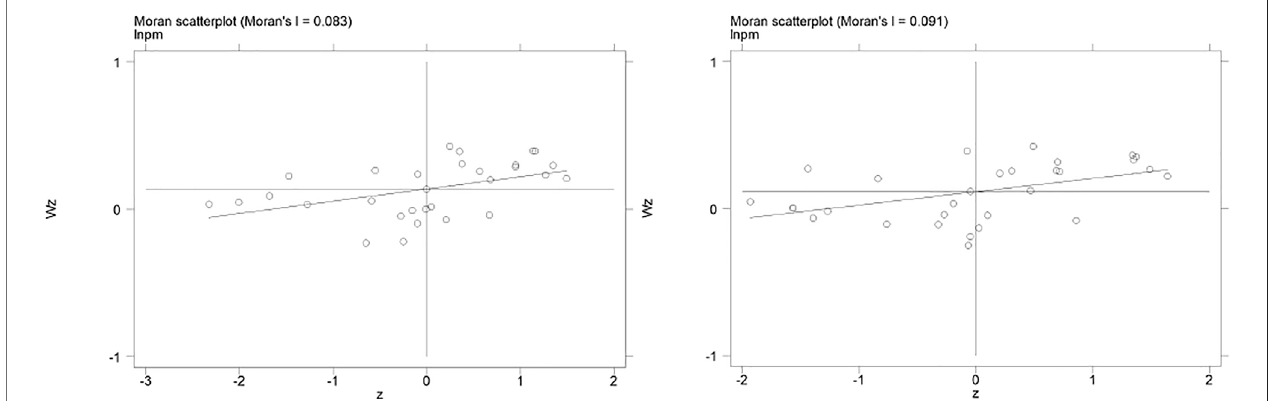
FIGURE 4 | Local Moran ’ I of PM2.5 concentration.